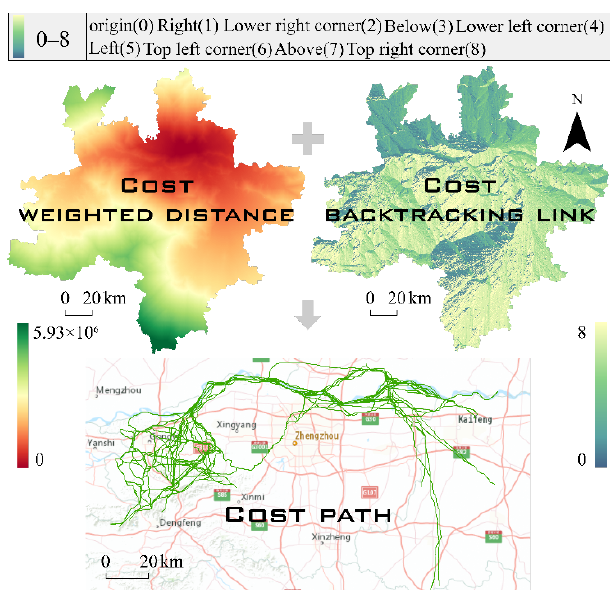
Figure 5. Cost path formation.